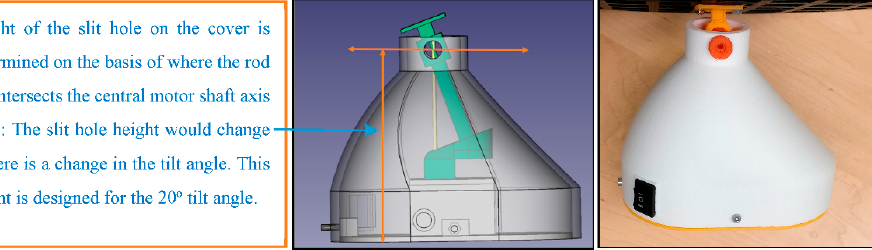
Figure 5. Cover design (left) and 3-D printed cover assembled detail (right).